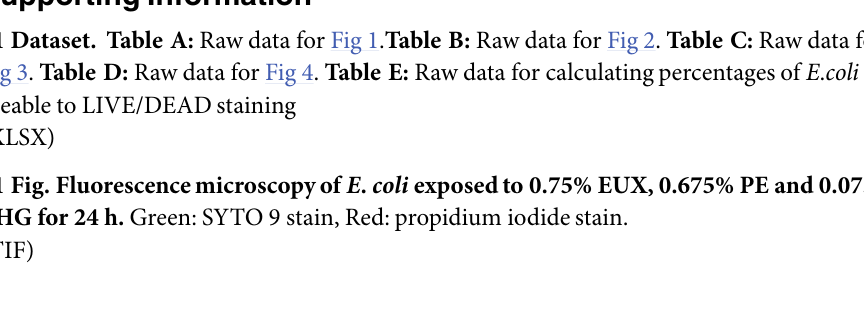
Fig 3. Table D: Raw data for Fig 4. Table E: Raw data for calculating percentages of E . coli per- meable to LIVE/DEAD staining S1 Fig. Fluorescence microscopy of E . coli exposedto 0.75% EUX, 0.675% PE and 0.075% EHG for 24 h. Green: SYTO 9 stain, Red: propidium iodide stain.